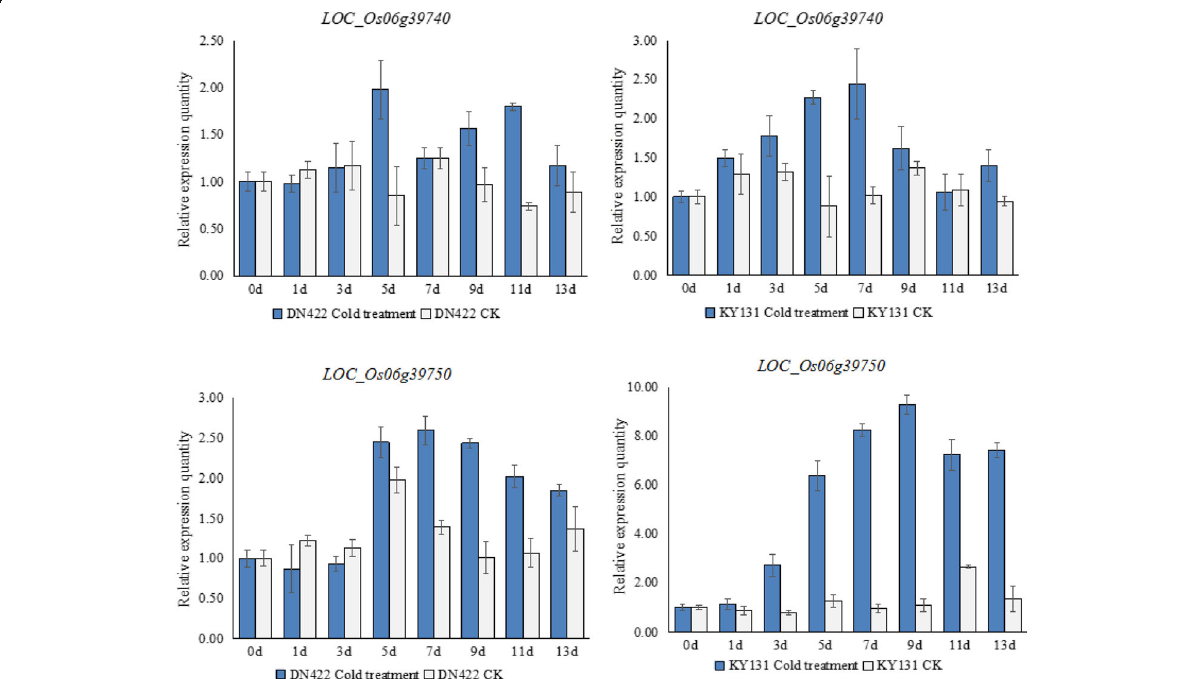
Fig. 5 Expression patterns of LOC_Os06g39740 and LOC_Os06g39750 under the conditions of cold water irrigation and CK. Each line with different patterns on the X-axes from left to right indicate the sampling times of 0, 1, 3, 5, 7, 9, 11 and 13 day after cold water irrigating in KY131 and DN422. The Y-axes indicate the relative expression quantity. The error bars indicate SD for the data obtained in three biological